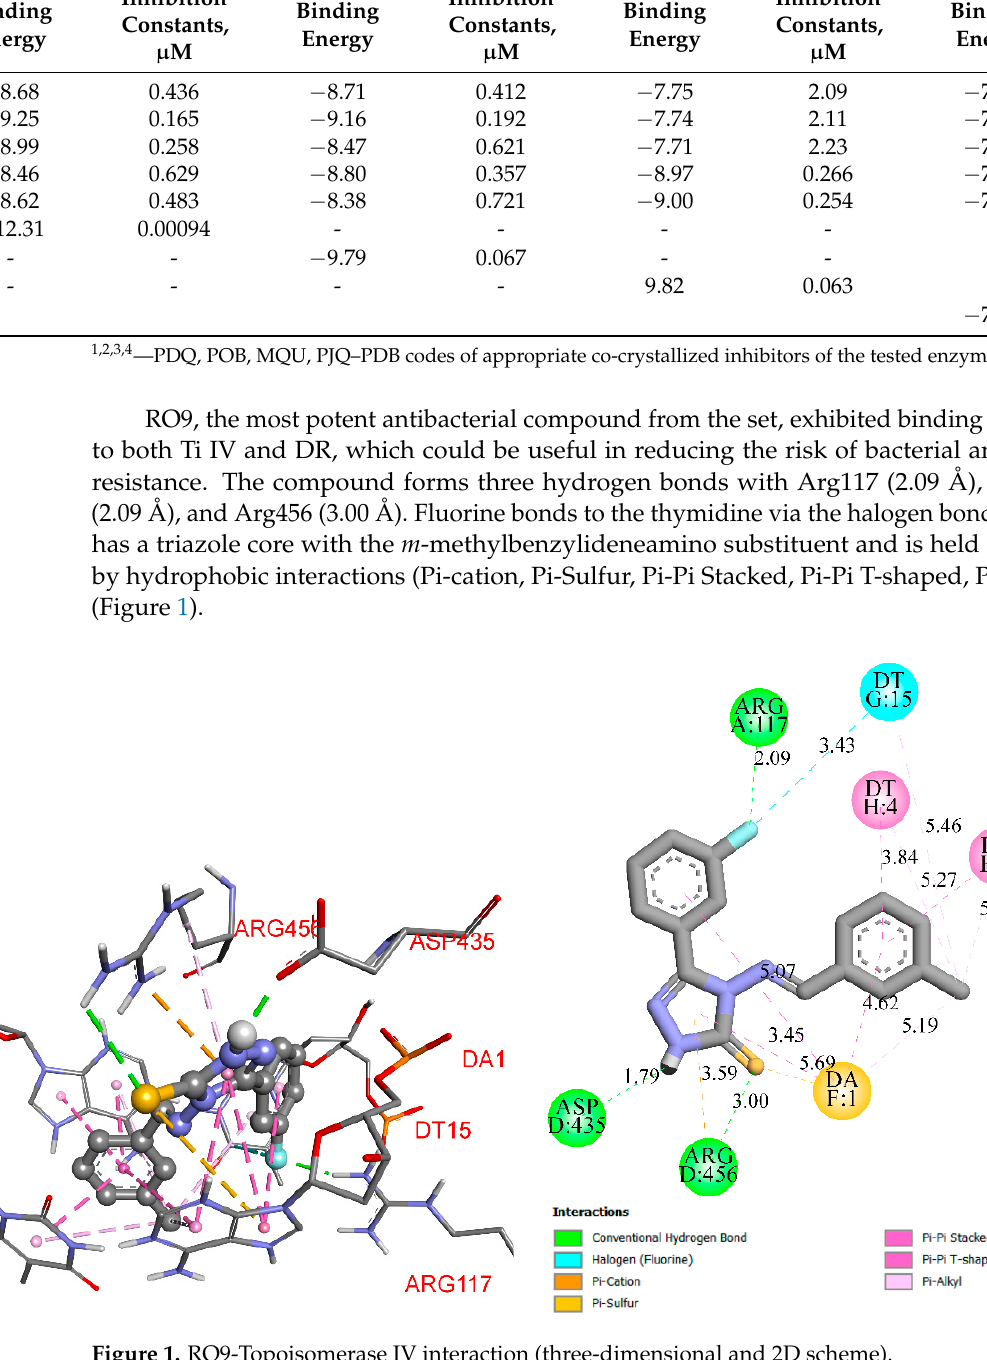
Figure 1. RO9-Topoisomerase IV interaction (three-dimensional and 2D scheme).